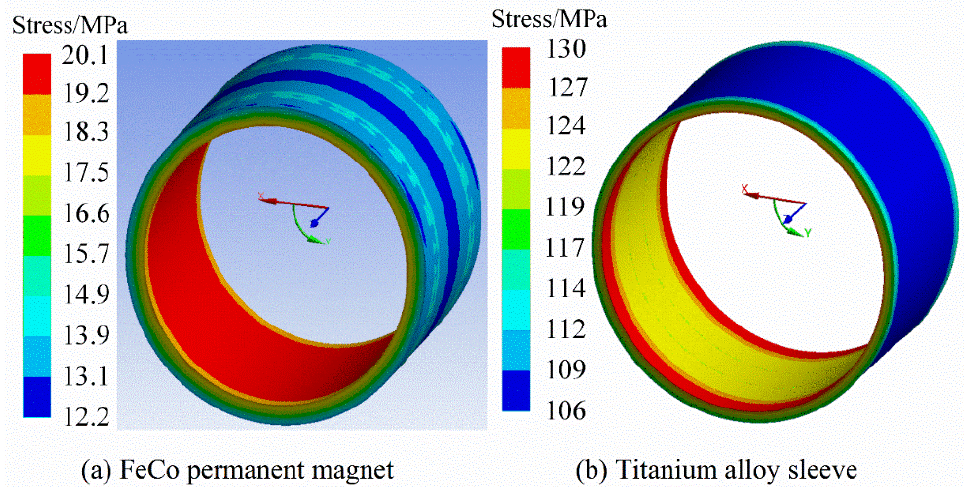
Figure 22. Rotor stress by coupled temperature-stress model. ( a ) FeCo-based PM stress, ( b ) Sleeve.